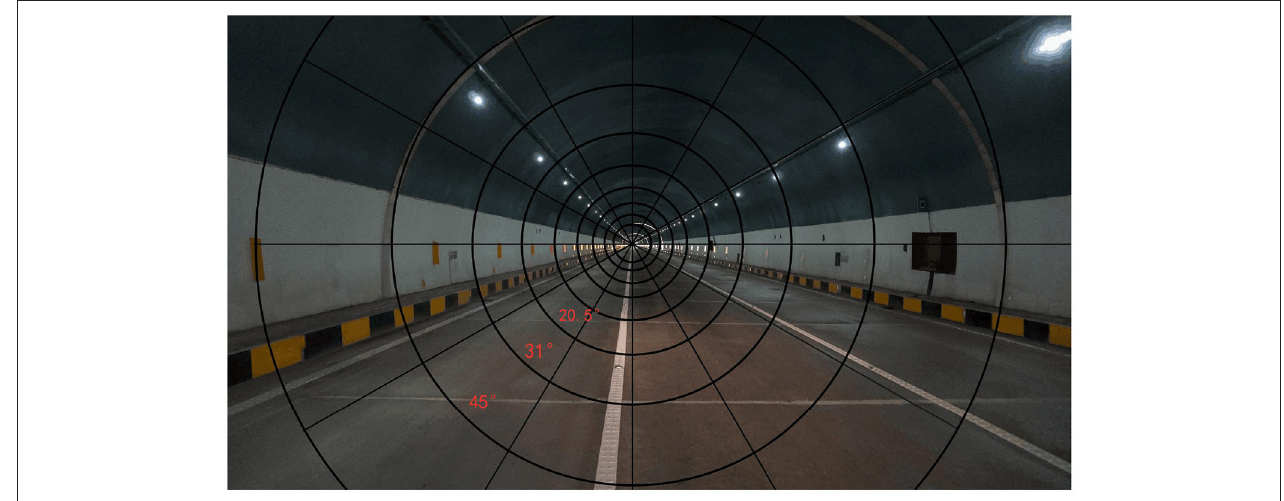
FIGURE 1 | The driver’s range of perception at different speeds.